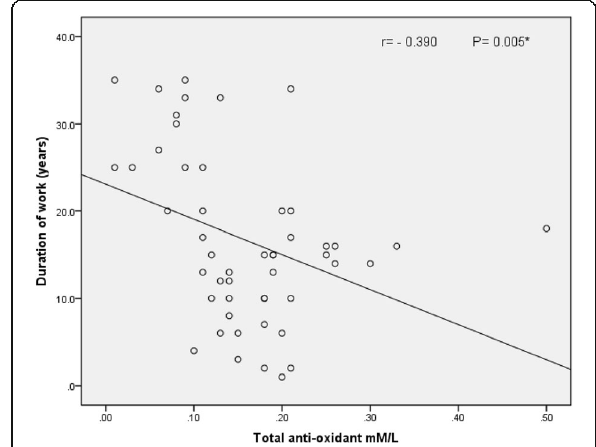
Fig. 5 Correlation between duration of work and total anti-oxidant capacity